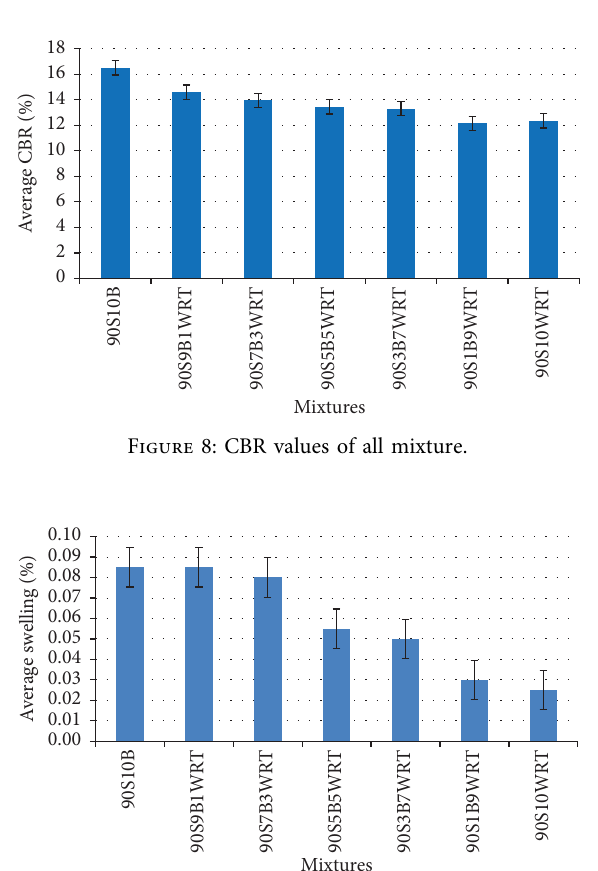
Figure 7: Splitting tensile strength versus curing period.